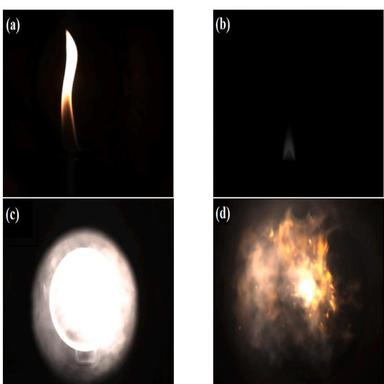
Flame image type. (a) Diffusion flame; (b) Tempering flame; (c) Stable flame; (d) Unstable flame.